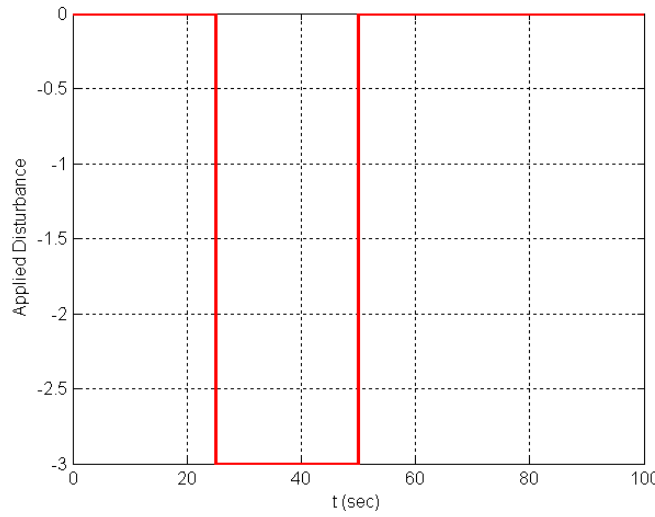
Figure 6. The applied external torque.